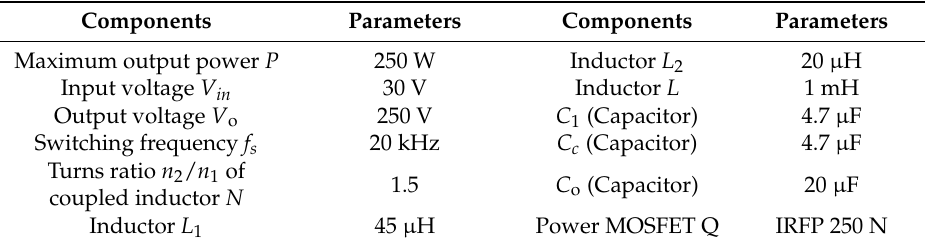
Table 2. Experimental